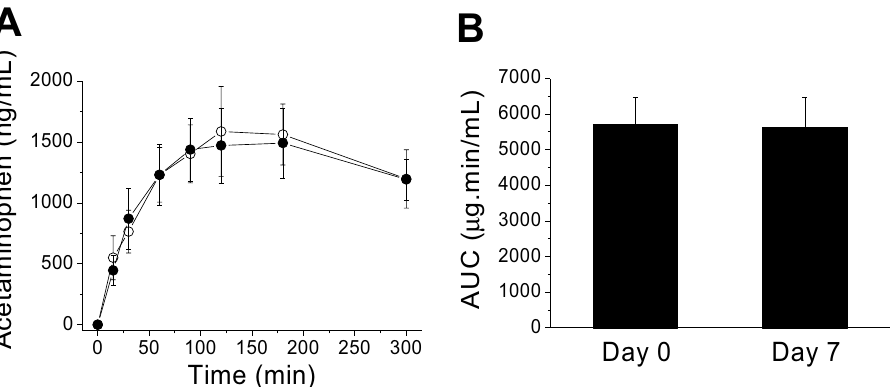
Figure 5. Time courses for plasma acetaminophen appearance ( A ) following a MMTT containing acetaminophen administration in two separate studies with one-week apart and comparison of the AUCs of plasma acetaminophen concentrations obtained from the two MMTT studies in one cohort of monkeys (n = 6). The patterns and time courses of plasma acetaminophen concentrations from two MMTTs were very similar. The AUCs of plasma acetaminophen concentrations showed no significant difference between two MMTTs by two-tailed Welch’s t-test ( p > 0.05, B ). Values are means ± SEM (n = 6). For the plasma acetaminophen responses, there was a significant time effect ( p < 0.001) but no significant difference ( p > 0.05) between the two MMTTs by Mixed-effects analysis followed by Sidak’s multiple comparisons